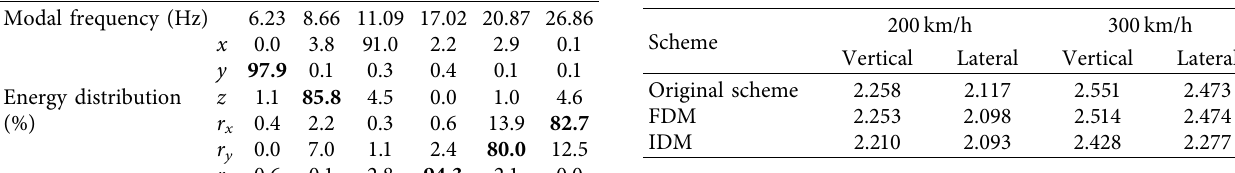
Table 3: Modal frequency and energy distribution of UCE by FDM.